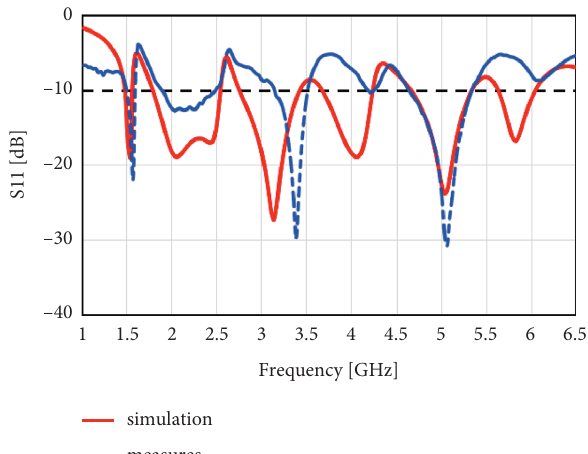
Figure 9: Comparison of simulation and actual measurement of the antenna.